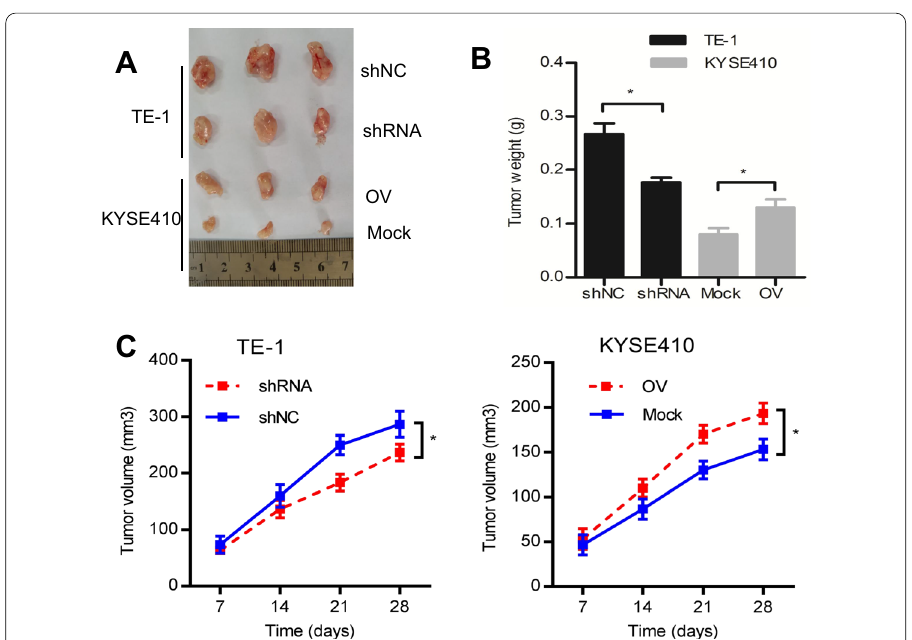
Fig. 4 β3GNT2 facilitates ESCA growth in vivo. A Representative images of the tumors (n Measurement of tumor weight in the xenograft model. C Quantitative analysis of tumor volume. Cells were transfected with the indicated plasmids. shNC, negative control shRNA; shRNA, β3GNT2 shRNA2 lentiviral vector; Mock, empty plasmid; OV, pcDNA3.1/β3GNT2 plasmid. Data are expressed as mean